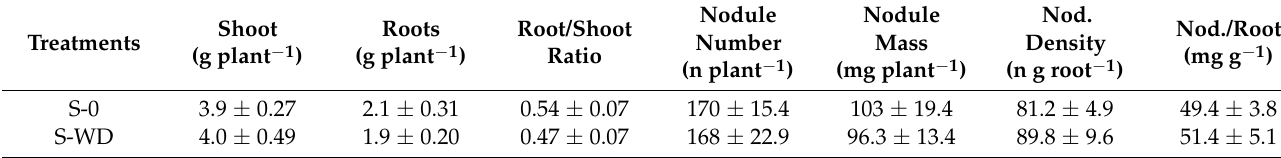
Table 7. Shoot and root biomass and nodule traits of the field bean as affected by the application of wood distillate (WD) as soil irrigation in the pot experiment. Data are means ± SE of six replicates ( n =